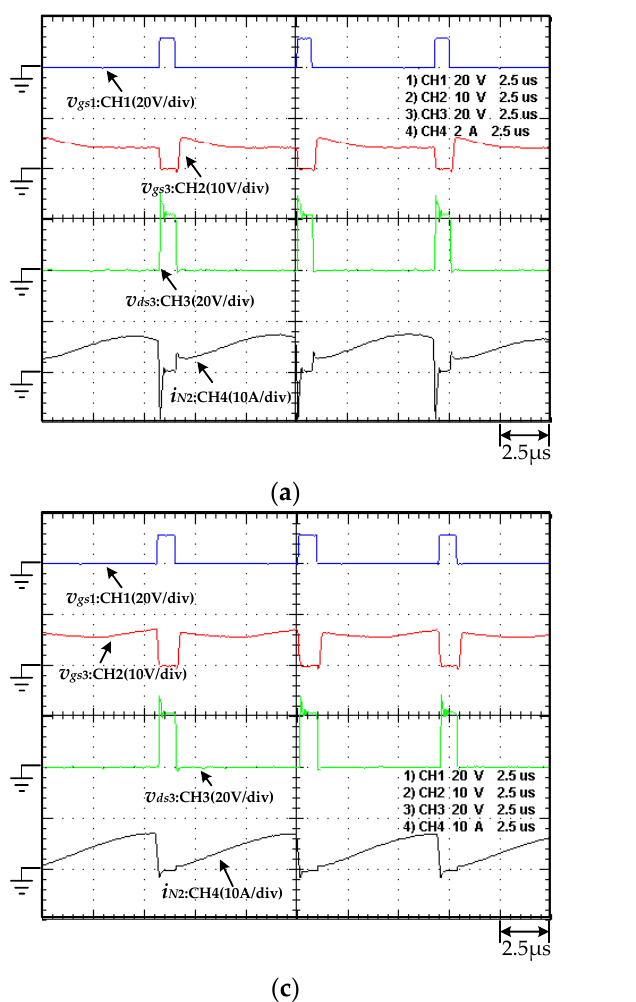
Figure 14. Measured waveforms of v gs 1 , v gs 2 , v ds 3 , and i N 2 at input 48 V under ( a ) 10% load; ( b ) 20% load; ( c ) 50% load; and ( d ) 100% load.